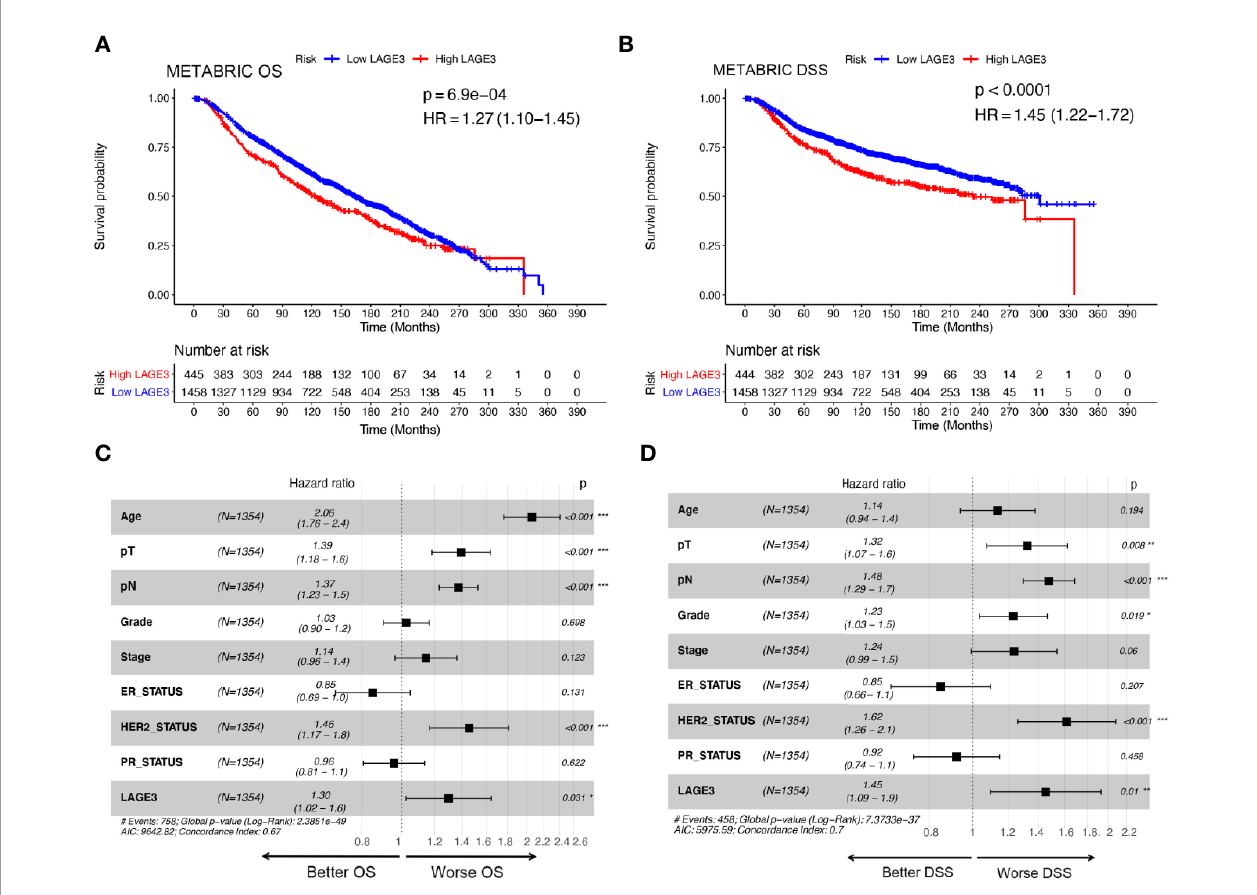
FIGURE 5 | Prognostic value of LAGE3 in BC patients in the METABRIC cohort. (A, B) OS and RFS between LAGE3 high and low groups. Multivariate Cox regression analysis of LAGE3 expression for (C) OS and (D) DSS in BC patients. OS, overall survival; DSS, disease-speci fi c